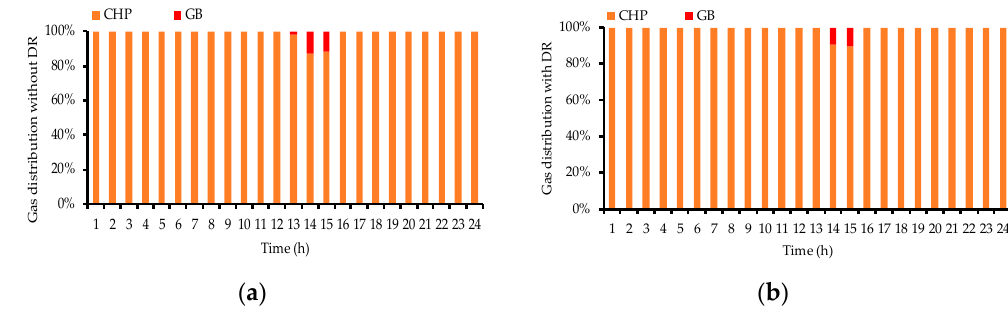
Figure 9. Natural gas distribution ratio: ( a ) without DR; ( b ) with DR.